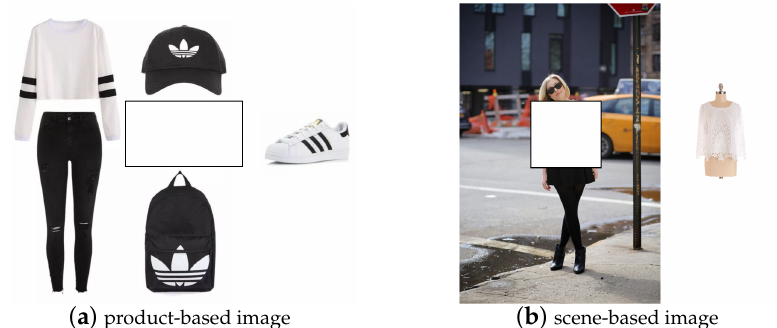
Figure 1. Two types of incomplete outfit images with a query box, with the ground-truth item listed beside the outfit. As shown in ( a ), traditional outfit completion methods focus on high-quality product-based images. Our model focuses on outfit completion in ( b ), where scene information and the full-body human subject are provided in the